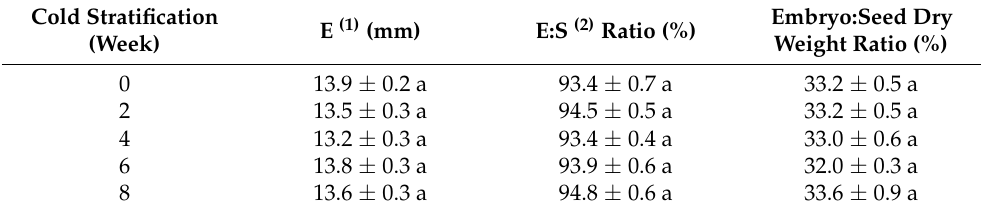
Table 1. Changes of F. rhynchophylla seed embryo development during cold stratification.